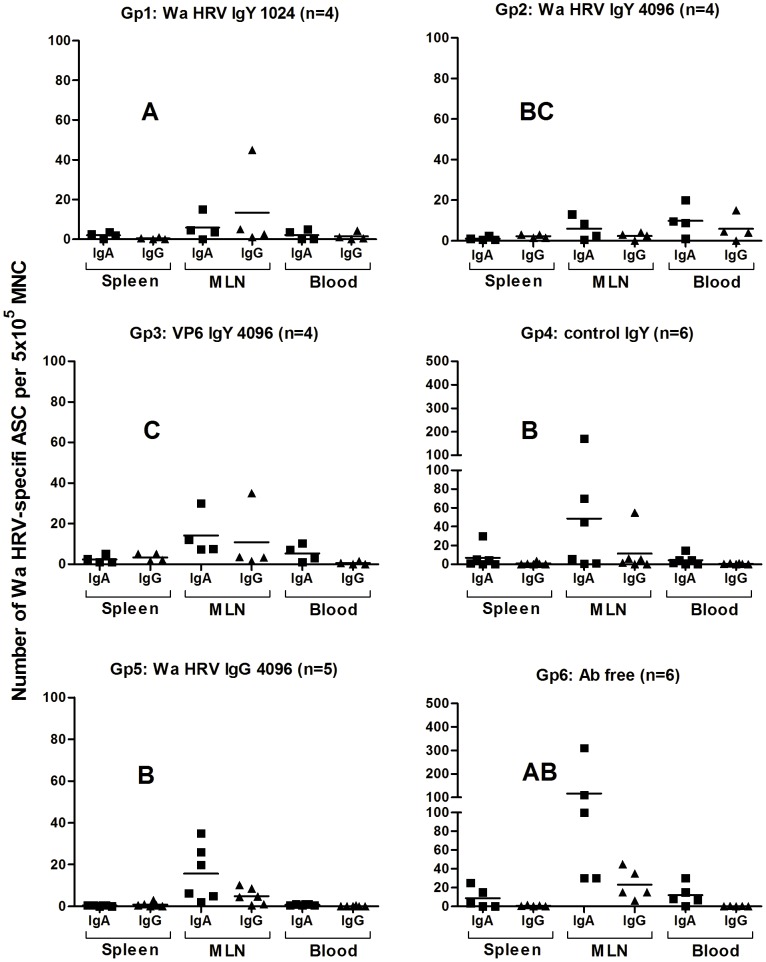
Numbers of Wa HRV-specific ASC per 5×105 MNC obtained from systemic lymphoid tissues (Blood and Spleen) and MLN draining the small and large intestine at 21 PID.For each tissue, when comparing ASC numbers of the same isotype among treatment groups different letter indicate a significant difference (Kruskal-Wallis rank sum test, p<0.05). n = number of piglets in each group. The IgM ASC response was not included as no IgM ASC were detected in most of the groups of pigs.